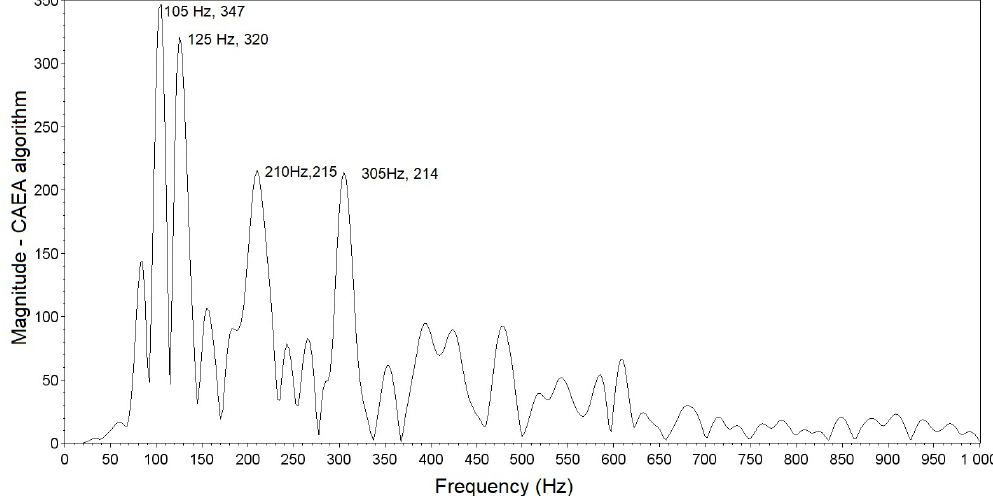
Figure 14. Frequency spectrum of the signal obtained by the CAEA algorithm (FFT